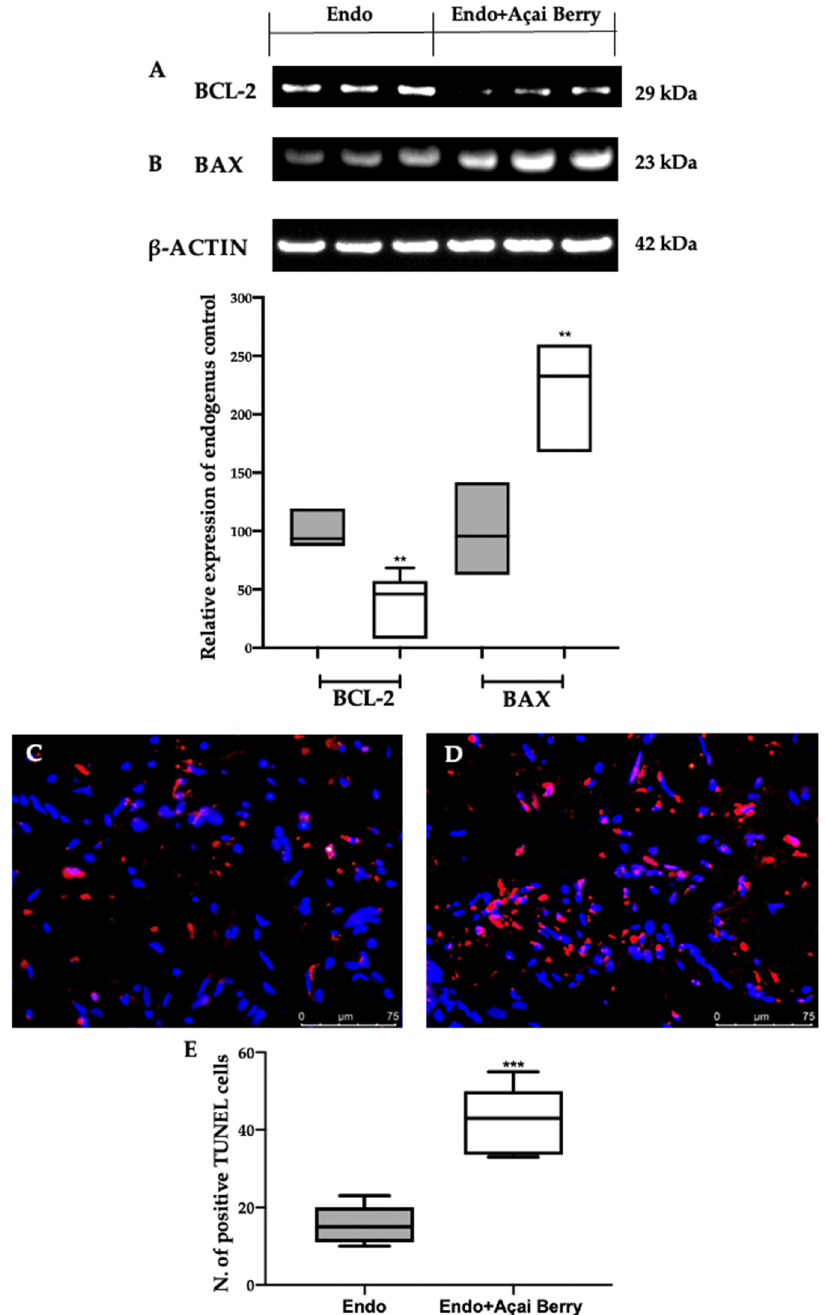
Figure 7. Analysis of Açai Berry administration on apoptosis impairment: Western blot analysis of BCL-2 ( A ) and BAX ( B ) expression. TUNEL assay: Endo ( C ), Endo + Açai Berry ( D ) and TUNEL- positive cells ( E ). A p -value of less than 0.05 was considered significant. ** p < 0.01 vs. Endo, *** p < 0.001 vs. Endo.